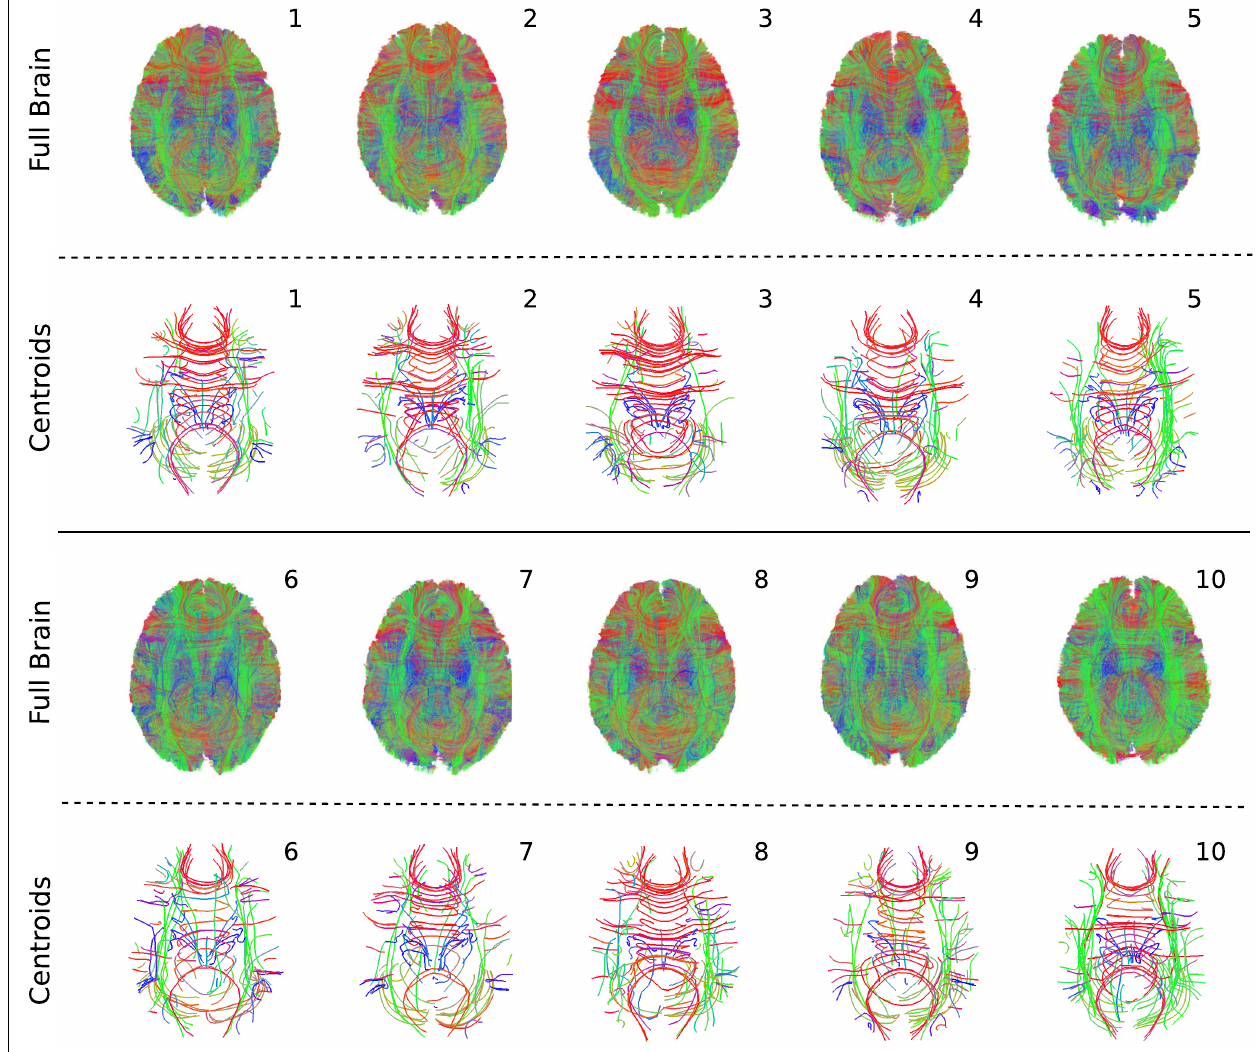
streamlines find the closest streamlines using the MAM